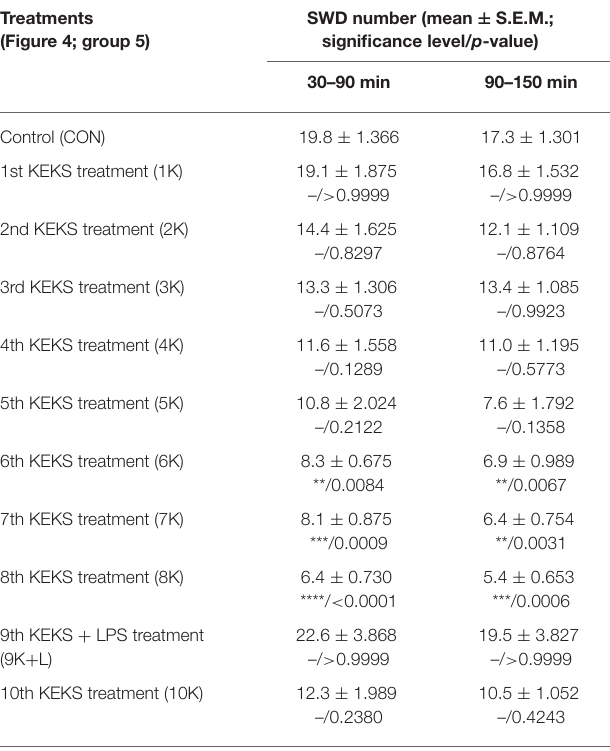
TABLE 6 | Effect of KEKS food on IP lipopolysaccharide-evoked changes in SWD number on the 9th KEKS day (9K + L; Figure 4 , group 5). Treatments (Figure 4; group 5)